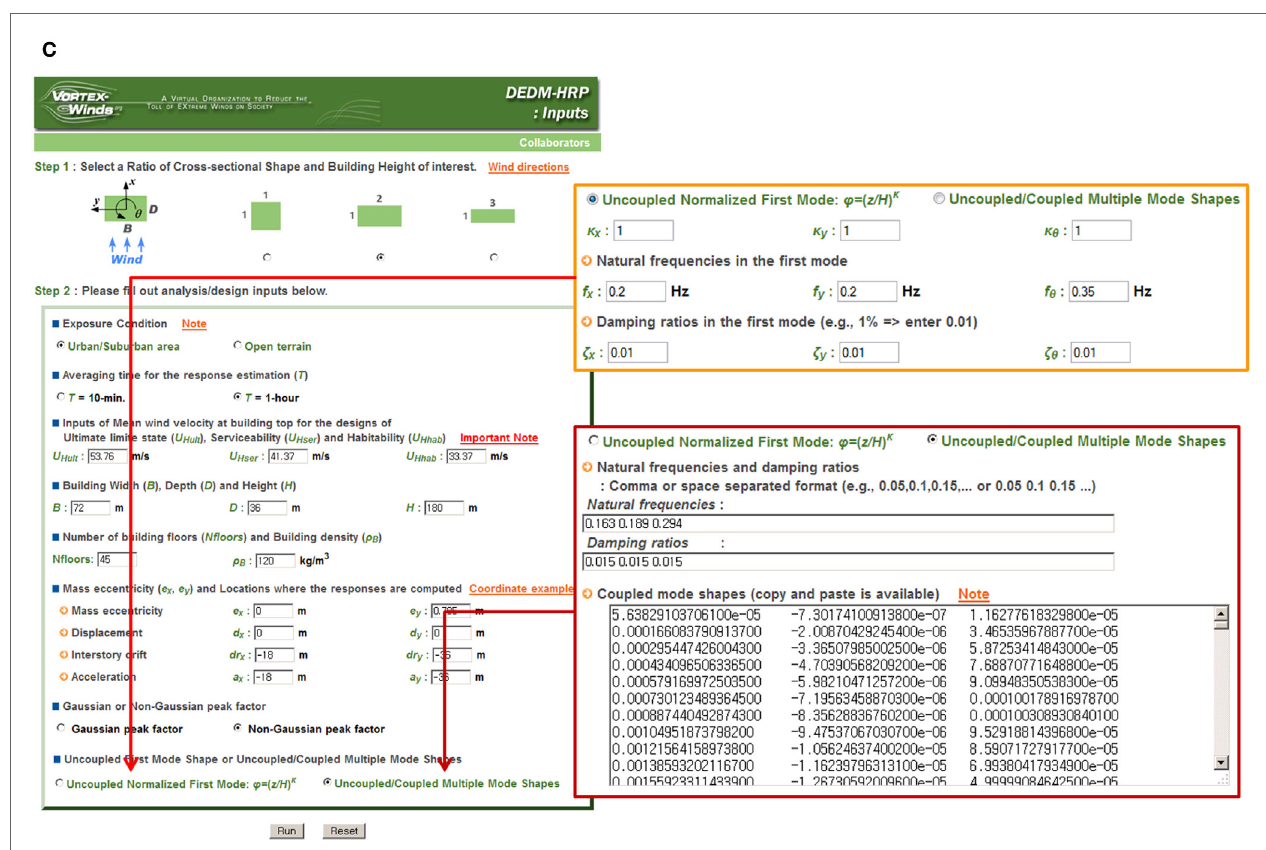
FigUre 5 | Examples of web-enabled Database-enabled design user interfaces (a) NatHaz aerodynamic loads database v. 2.0; (B) Database-enabled design module for high-rise. (c) User interface of Database-enabled design module for high-rise building with pressure